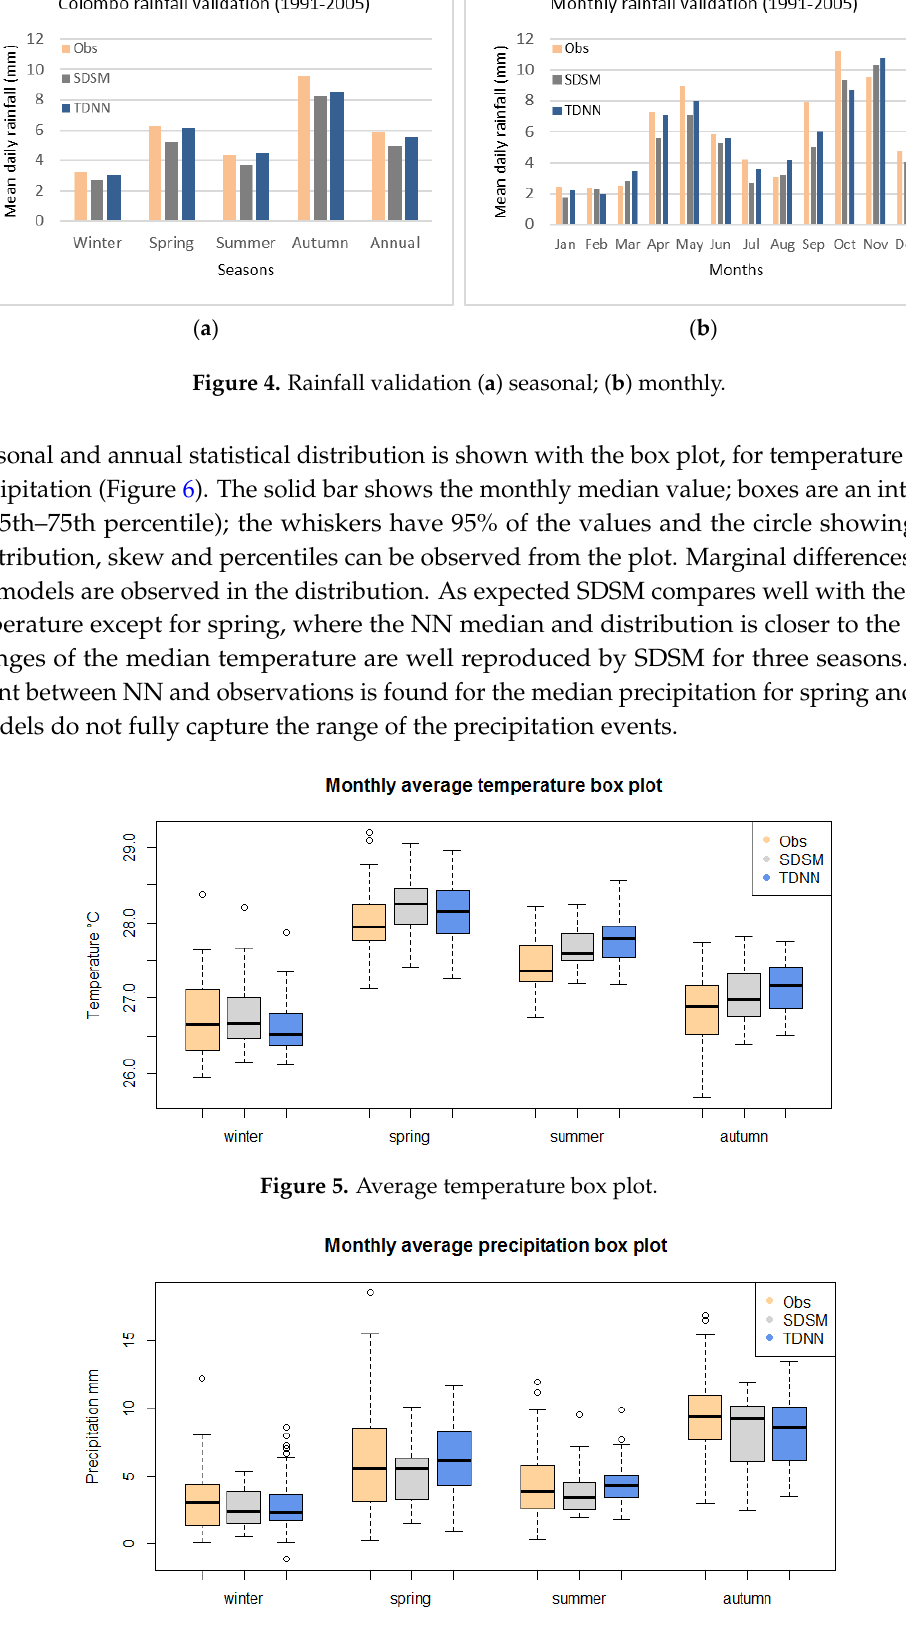
Figure 6. Average precipitation box plot. Table 4. Future projections of increase in average temperature and rainfall.